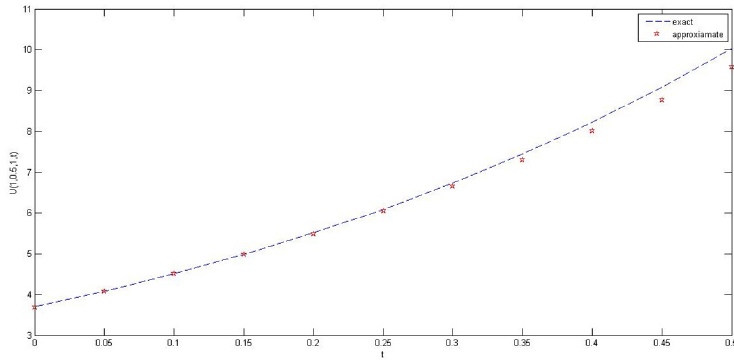
Figure 4. Exact solution and third approximate solution for α =